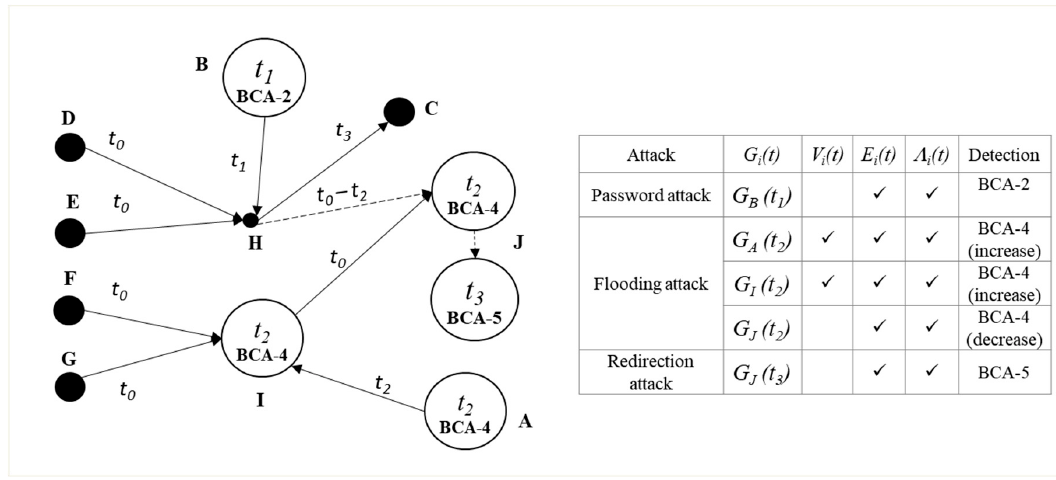
Figure 12. Detection of unknown attack.